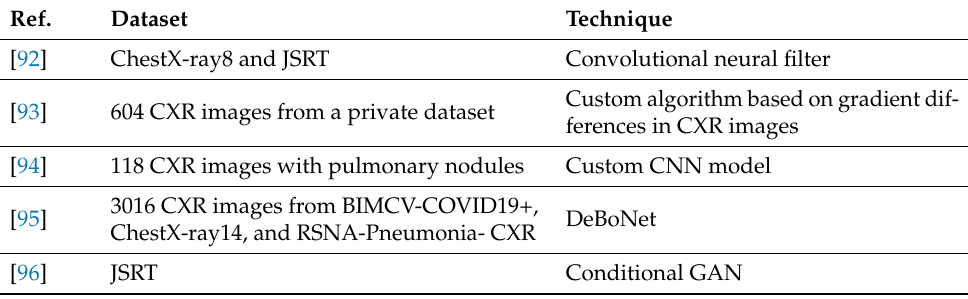
Table 6. Overview of different bone suppression techniques for CXR images.